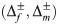
Visualization of the parameter configurations covered by Table 1 as points in the (Δf±,Δm±)-plane.